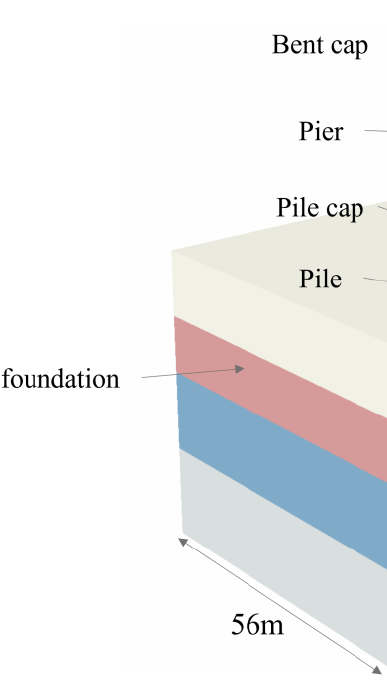
Figure 17. Deformation of Pier P30.